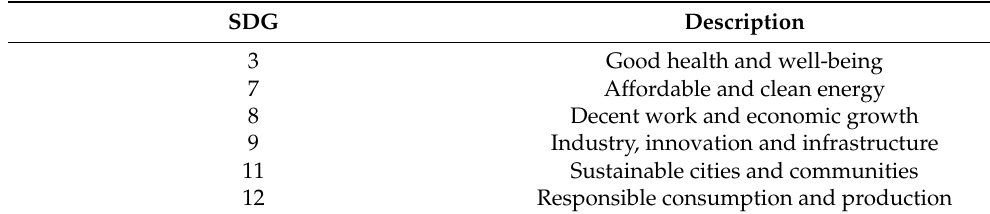
Table 1. SDGs linked to sustainable